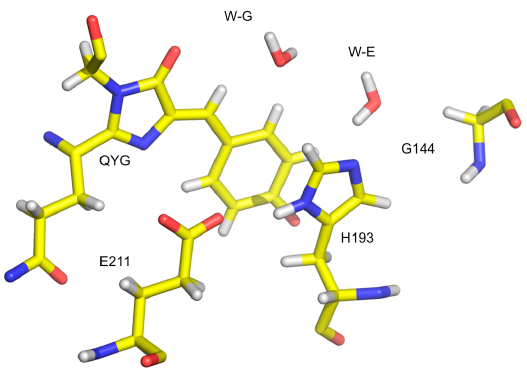
Figure 4. The chromophore pocket of Dathail shows interactions to amino acid residues and organization and orientation of key water molecules. Figure generated from PDB 4ebj